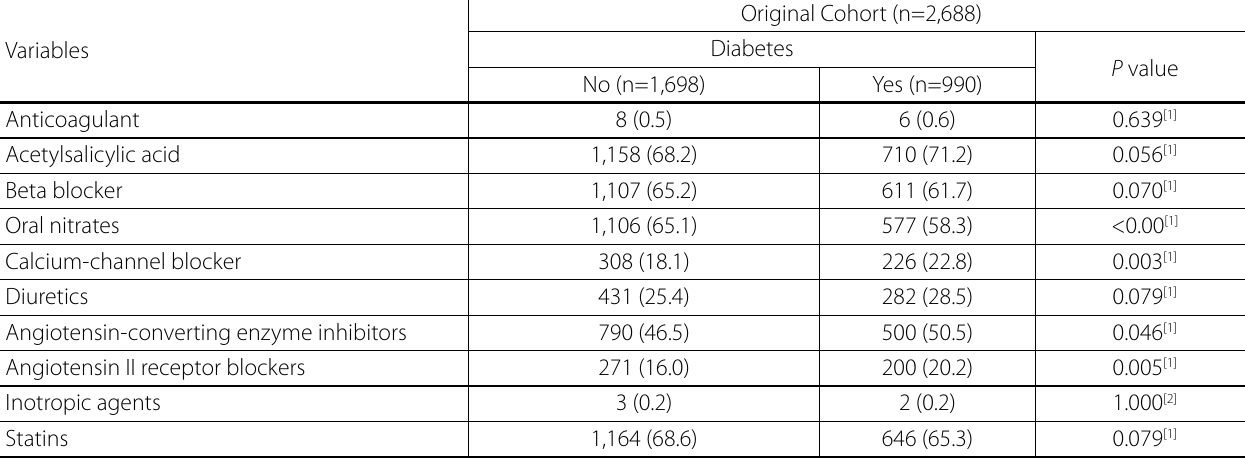
Table 2. Absolute and relative frequencies of the use of medications in the preoperative period according to the study group.